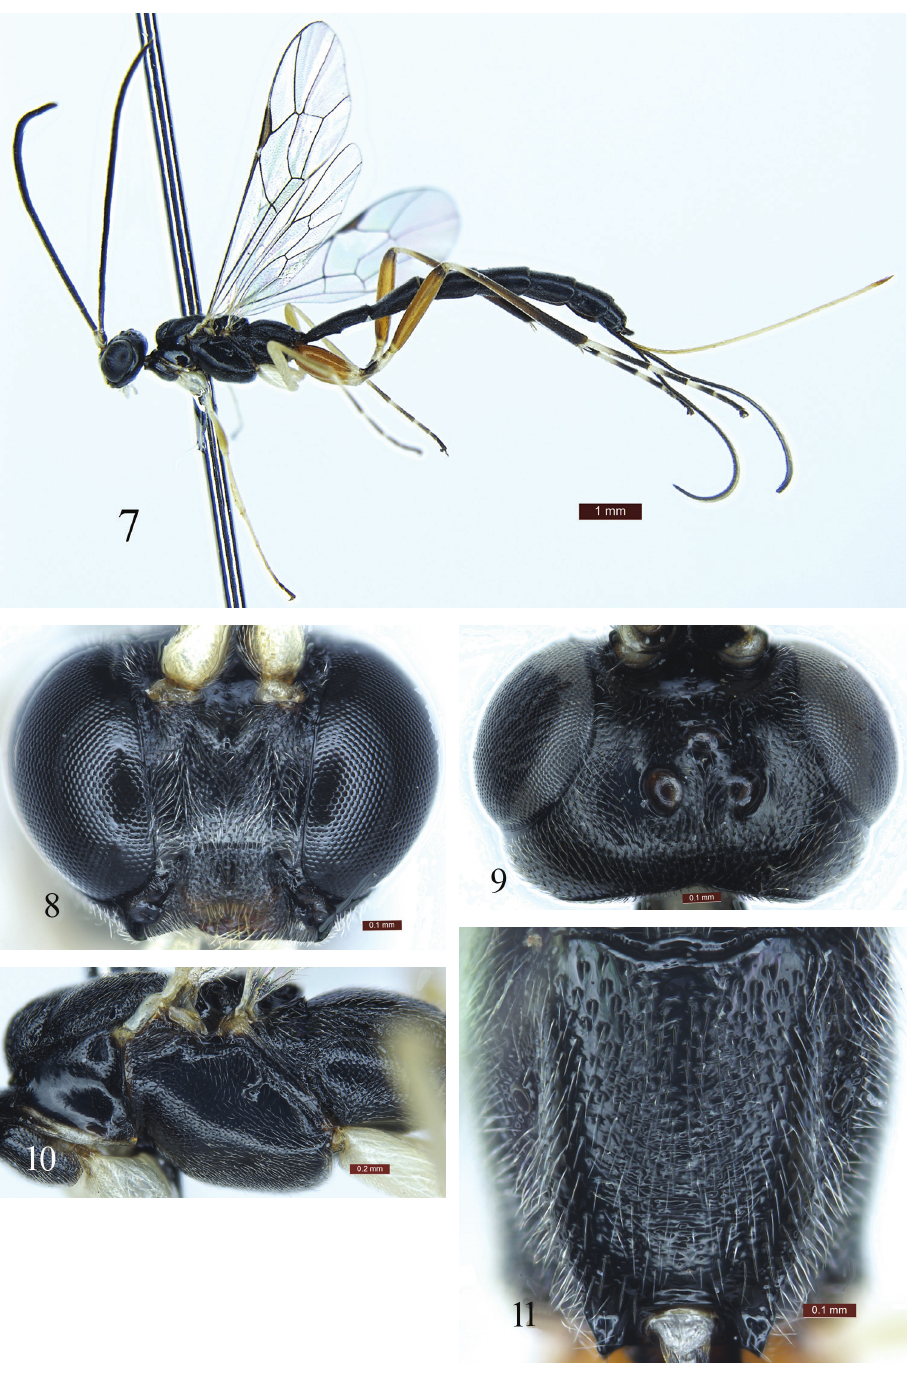
Figures 7–11. Poemenia quercusia Sun & Sheng, sp. n. Holotype. Female. 7 Habitus, lateral view 8 Head, anterior view 9 Head, dorsal view 10 Mesosoma, lateral view 11